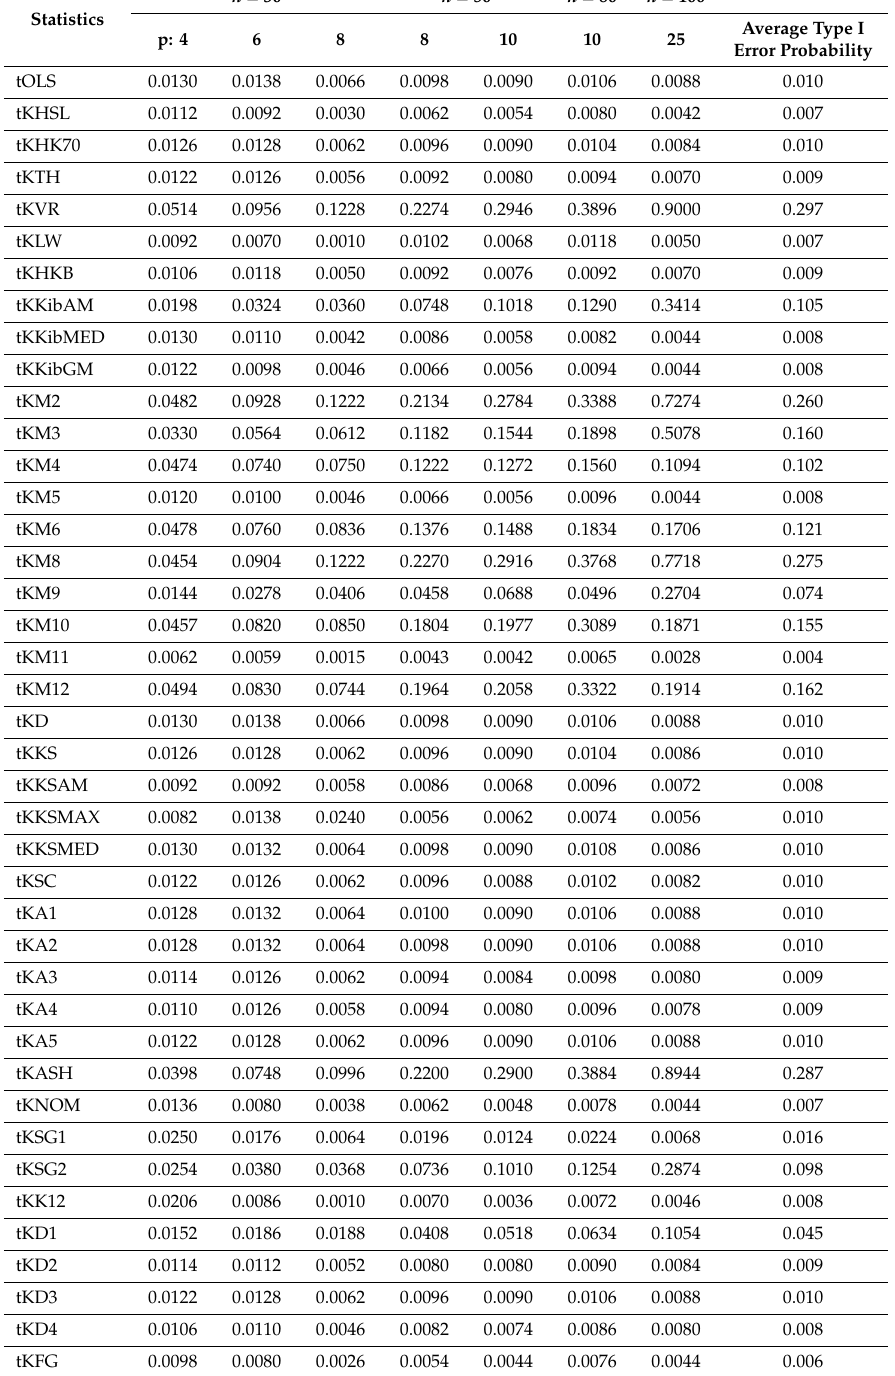
Table 4. Simulated Type I errors for ρ = 0.95 and α =